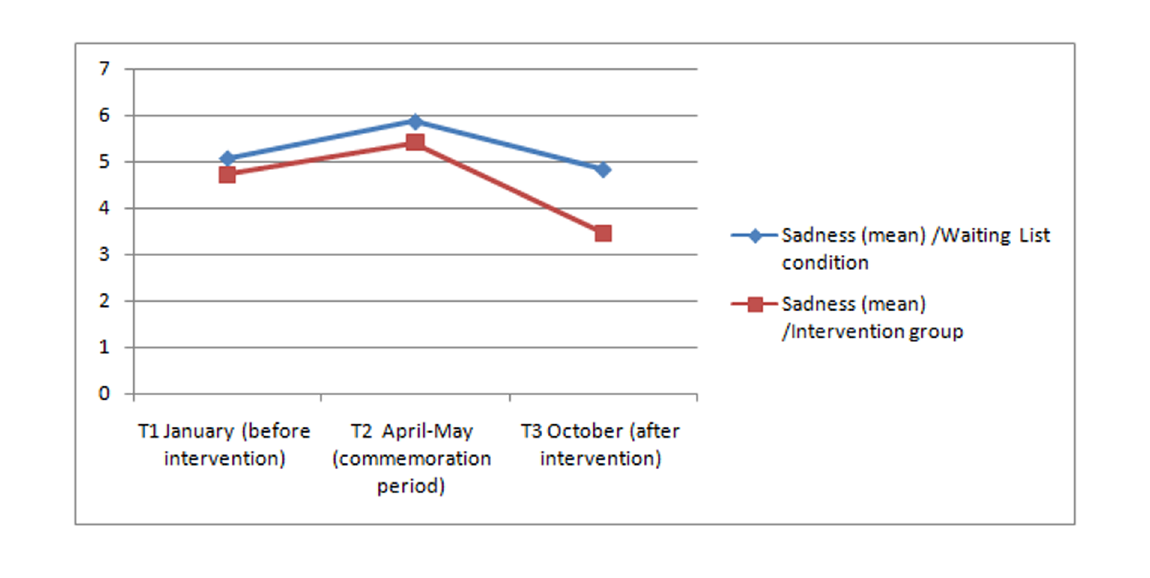
Figure 1. Sadness trends across the course of the study.